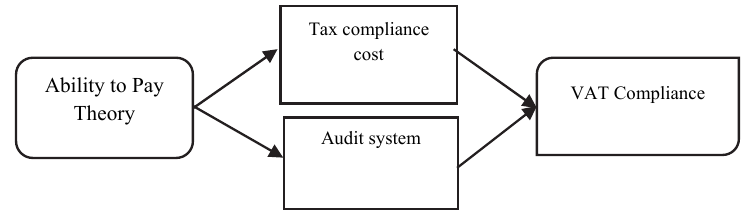
Fig. 3. Relationship between Tax Compliance Cost, Audit System, and Tax Compliance Under Ability to Pay